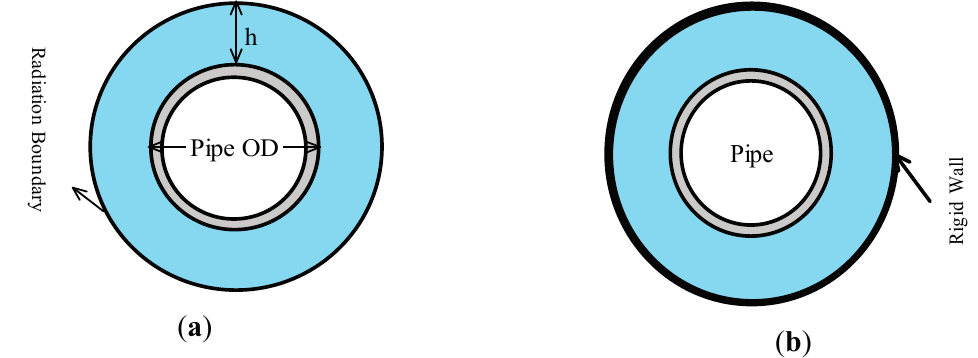
Figure 2. A submerged pipe with: ( a ) radiation and ( b ) rigid wall